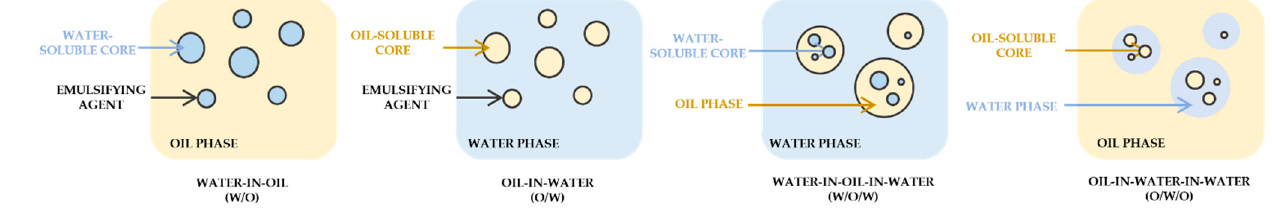
Figure 9. Illustration of emulsion